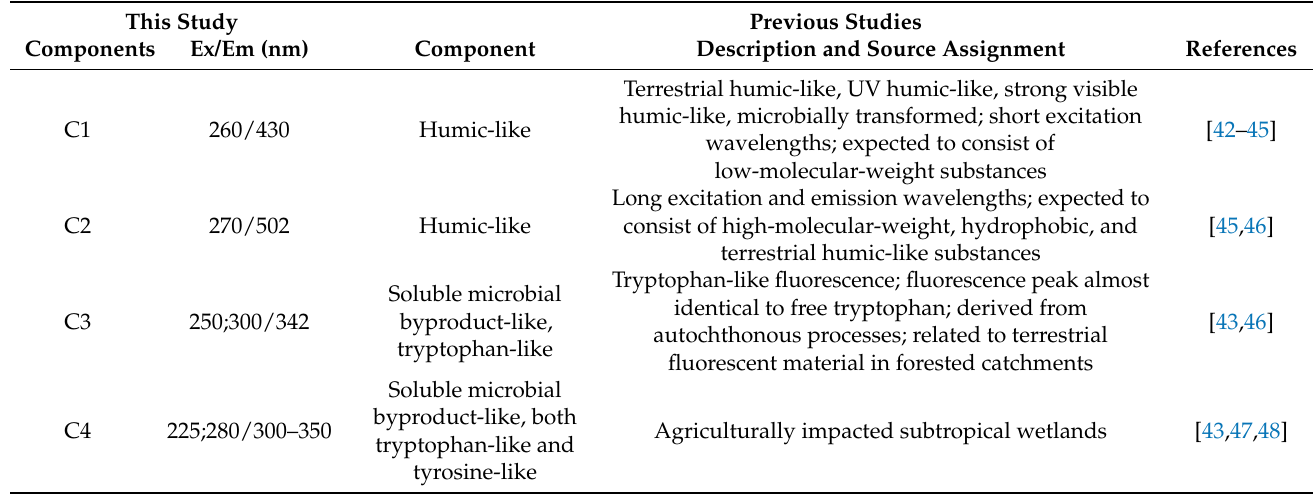
Figure 4. Proportions of fluorescence intensity for the four components (C1–C4) of water-extractable organic matter: ( a ) proportions of fluorescence intensity for Component 1; ( b ) proportions of fluo- rescence intensity for Component 2; ( c ) proportions of fluorescence intensity for Component 3; ( d ) proportions of fluorescence intensity for Component 4. Treatment abbreviations are defined in Fig- ure 1. Different lowercase letters indicate significant differences among the five organic amendment treatments ( p < 0.05). Different uppercase letters indicate significant differences among the three nitrogen fertilization treatments ( p < 0.05).